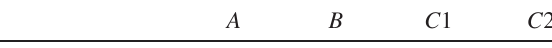
TABLE III. Responses to a variant of question 1 from the beginning of the first quarter of a graduate course on quantum mechanics. The correct answer ( C ) has been divided into two categories based on the reasoning students provided: category C 2 is considered correct with correct reasoning. (This distinction is described in more detail in the text.) A B C 1 C